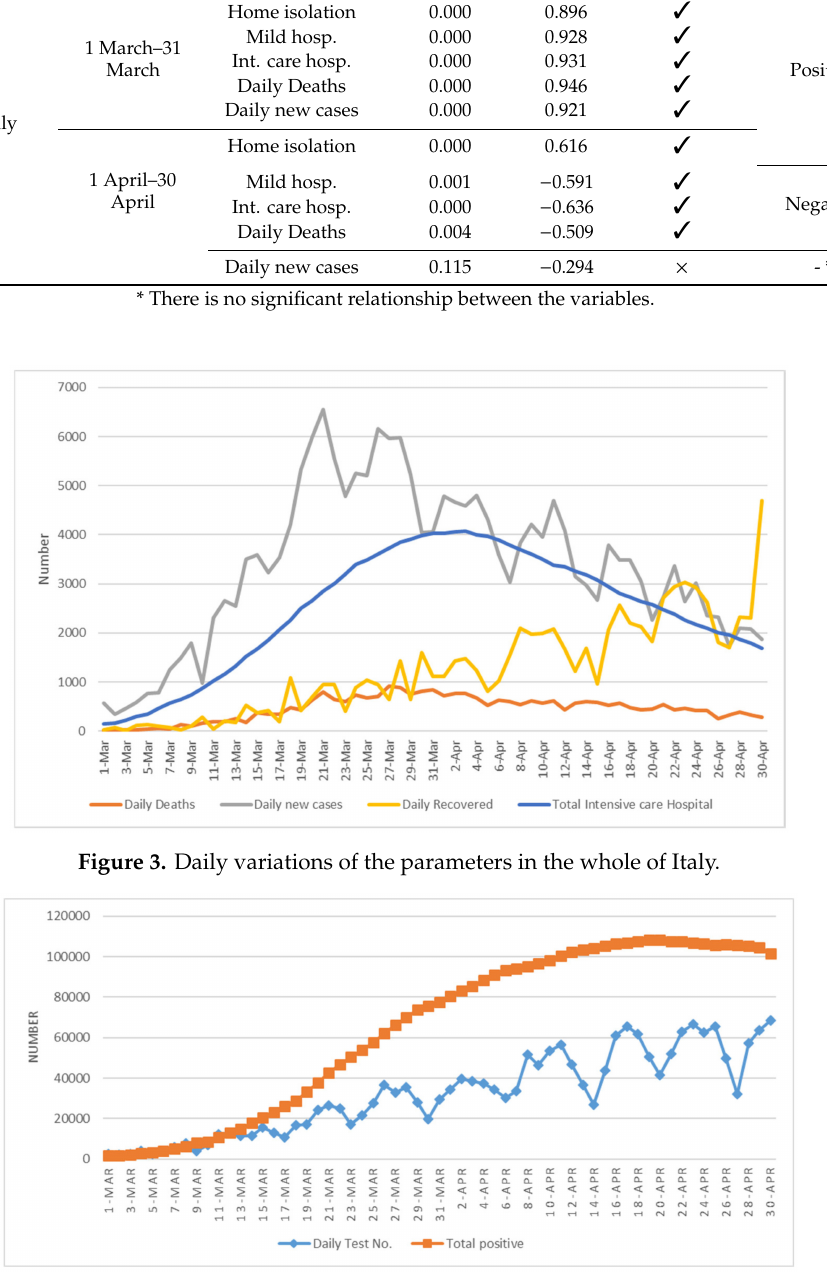
Dependent ANOVA Beta p -Value Variable